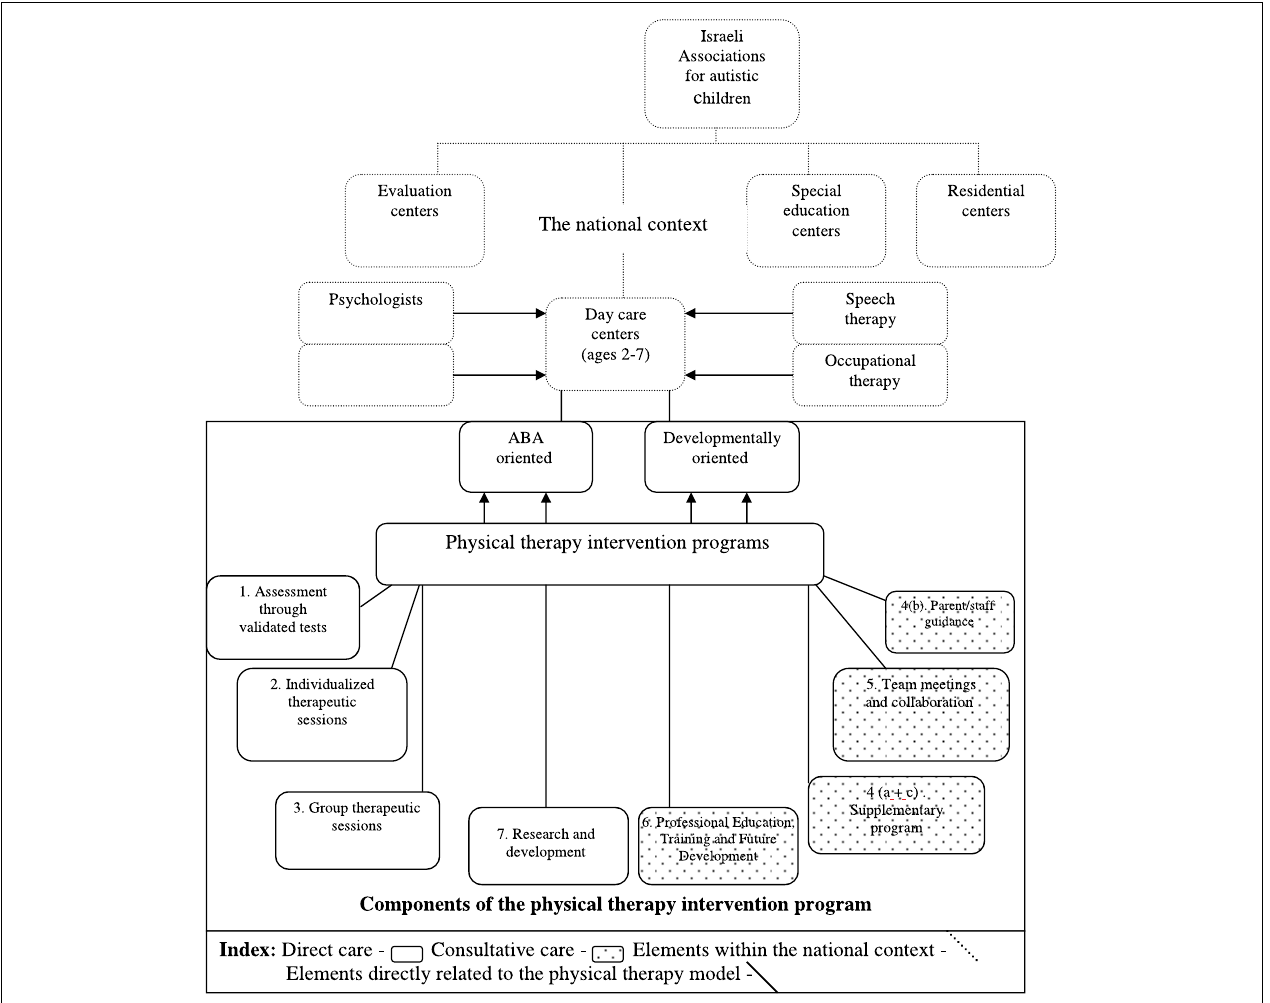
FIGURE 1 |A model of physical therapy services for children withASD in Israel